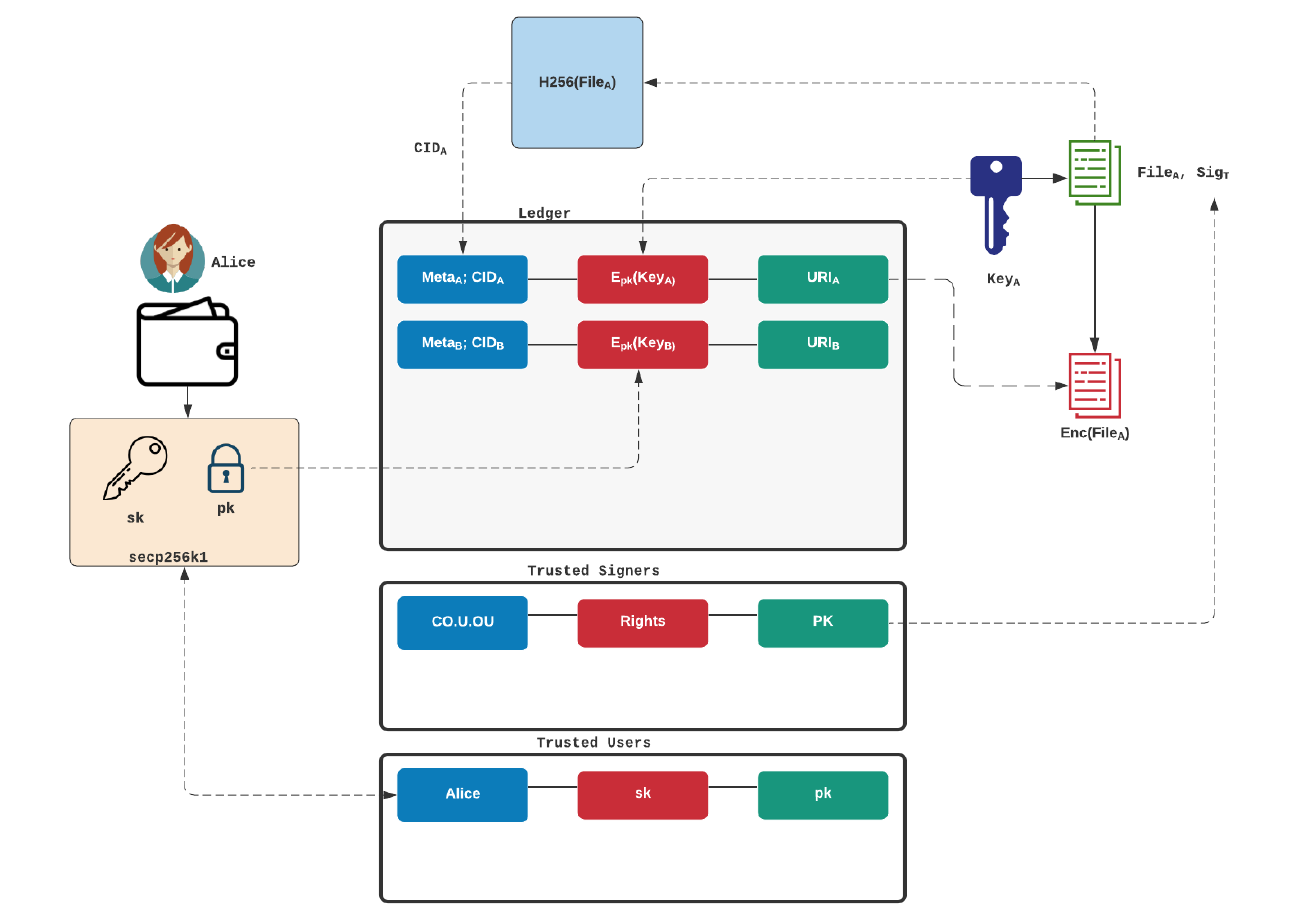
Figure 5. Overview of